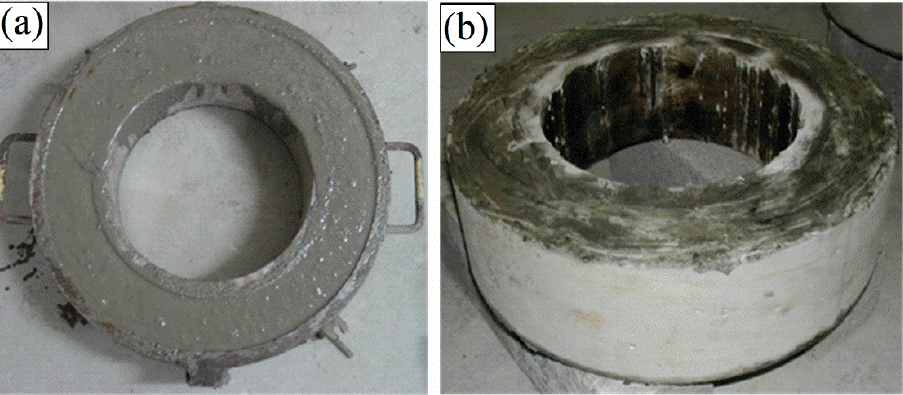
Figure 3. The restrained concrete rings: ( a ) the ring before demoulding and ( b ) the ring being test.